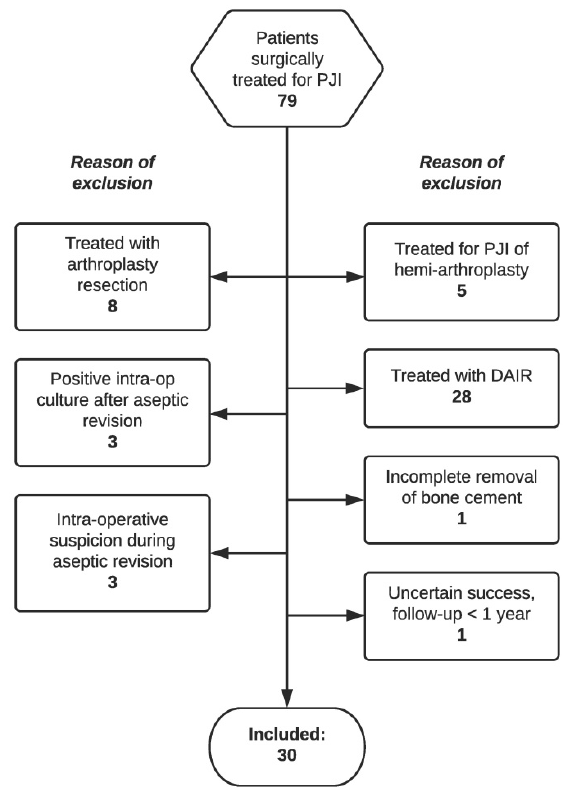
Figure 1: Flowchart of subject inclusion with